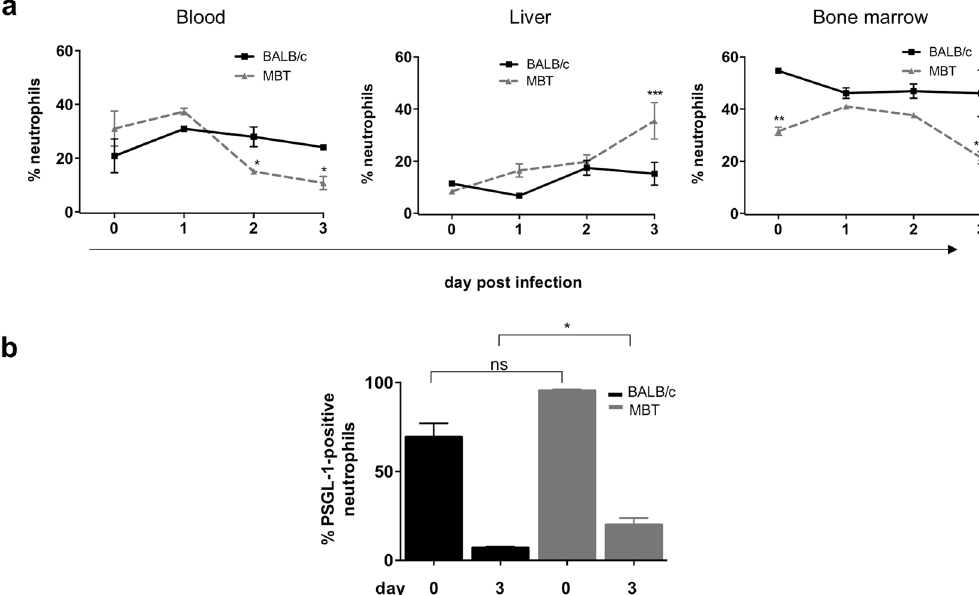
Figure 5. Faster recruitment of neutrophils, and higher PSGL-1 levels in neutrophils at day 3 post infection in MBT mice. ( a ) Flow cytometric profile of neutrophil (CD45 + , Ly6C/Ly6G + ) populations in the blood, liver, and bone marrow of RVFV-infected BALB/c and MBT mice on days 0–3 post infection. Two-way ANOVA was used to test differences between means (b) Percentages of PSGL-1-positive circulating neutrophils at day 3 post infection. Cytometry experiments were performed twice (n = 5 mice/strain/timepoint, unless otherwise indicated). Data are represented as mean ± SEM. Mann- Whitney U test was used to compare differences between means. * P < 0.05, ** P < 0.01, and *** P <